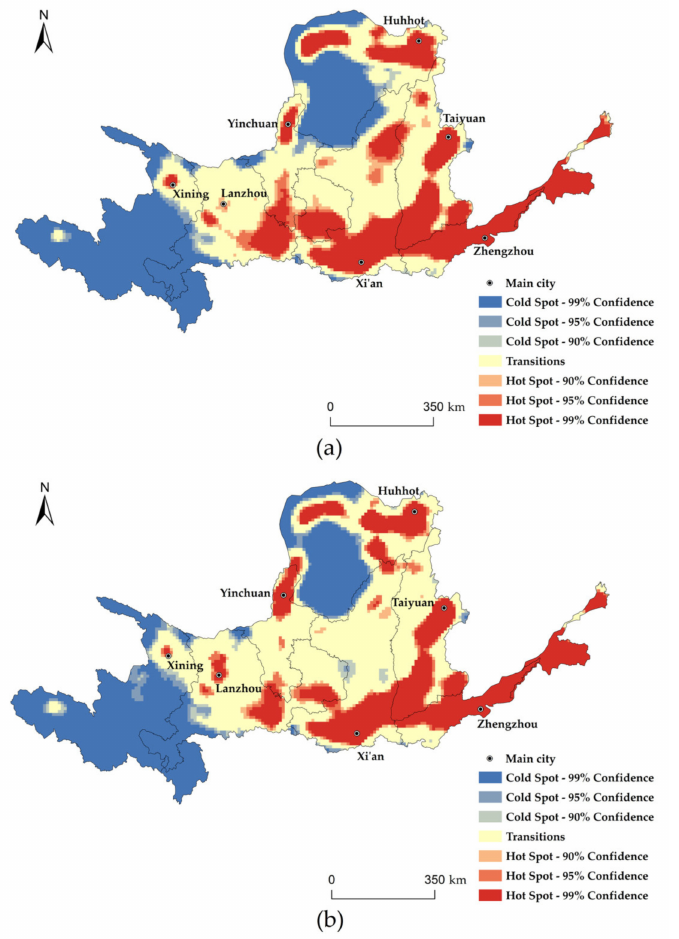
Figure 11. Hot spots distribution of land use benefits in the Yellow River Basin: ( a ) 1995; ( b )